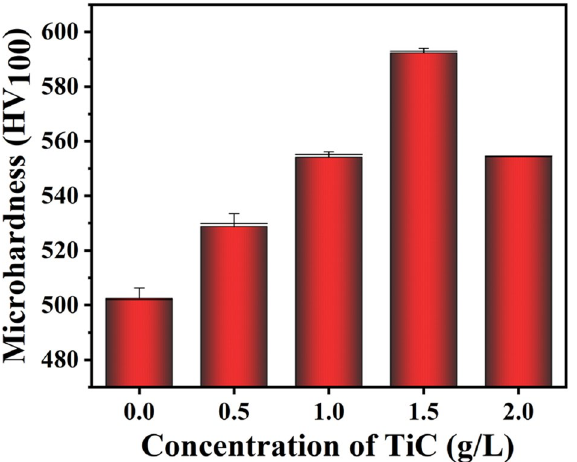
Figure 10. Vickers microhardness of Ni–P and Ni–P–TiC composite coatings containing various concentrations of TiC particles.